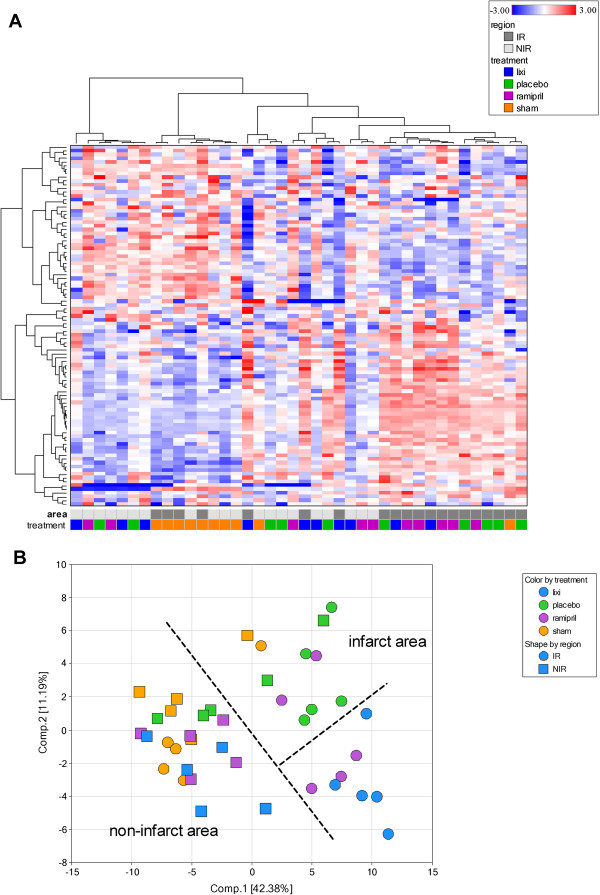
Gene expression patterns 10 weeks after ischemia reperfusion injury performed on all samples and comparing non-infarct area versus infarct area. (A) Determination of 92 representative genes followed by 2 dimensional hierarchical clustering and visualization as heatmap. Each sample forms a column and each gene forms a row with the heatmap intensities standardized within each gene. Overall 5 independent samples were measured for each group and two different tissue areas (infarct and non-infarct ventricular tissue) resulting in a final number of 40 samples. (B) Principle component analysis (PCA) of the same data reflecting the total expression changes into two uncorrelated principal components.